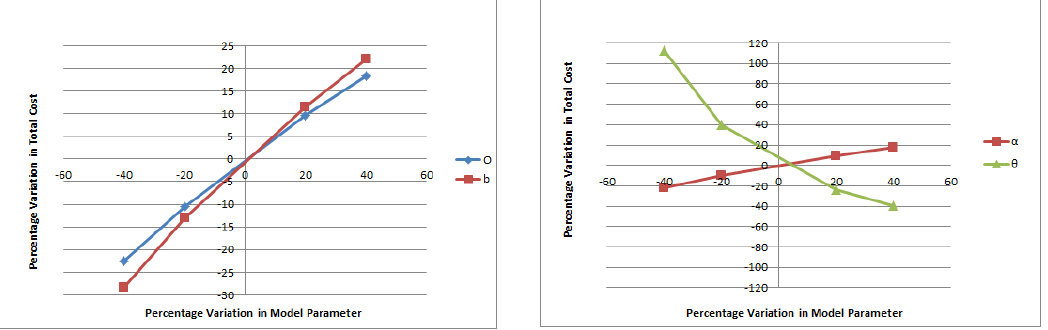
Figure 2: Percentage Variation in Model Parameters with Percentage Variation in Total